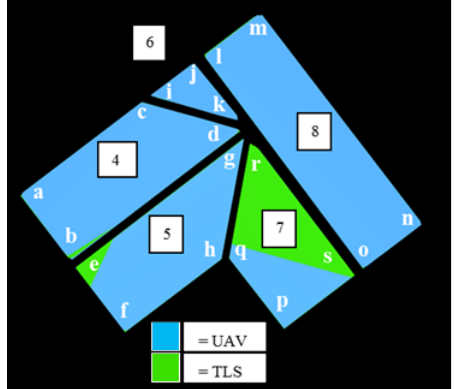
Figure 6. Comparing fitted planes of UAV and TLS points to roof faces of building 2. The interface between color change represents intersection of fitted planes. The statistical summary of the plane-fitting for roof faces of building 2 is given in Table